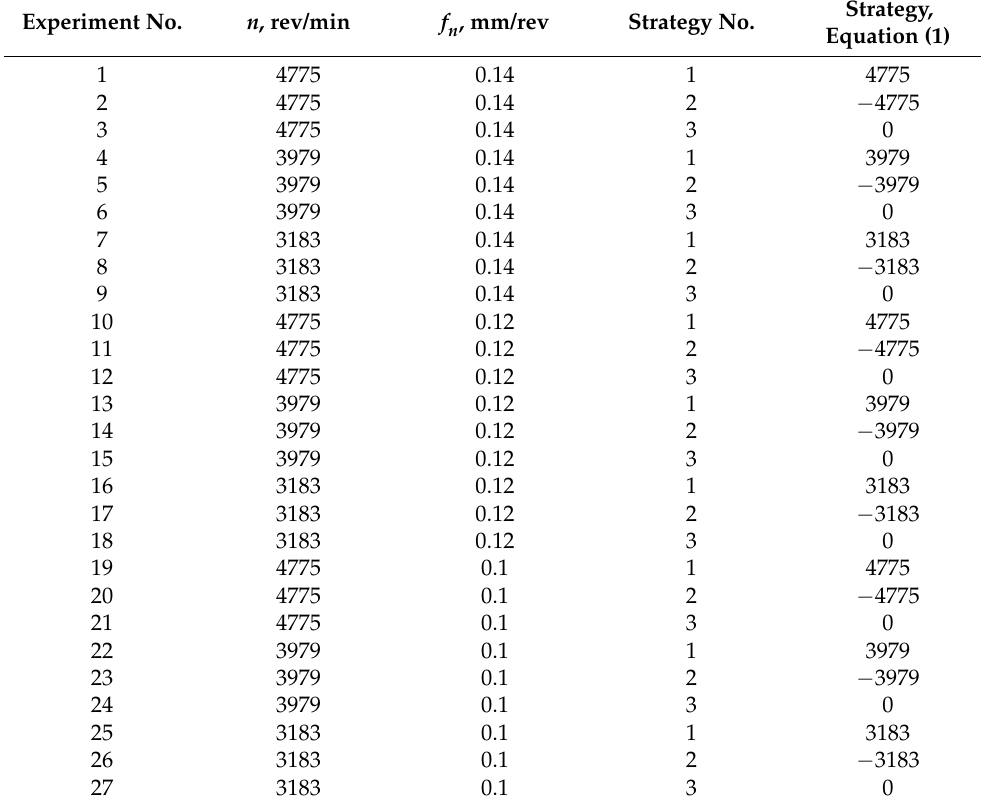
Table 2. Table 2. Factors considered in the drilling experiments. Experiment